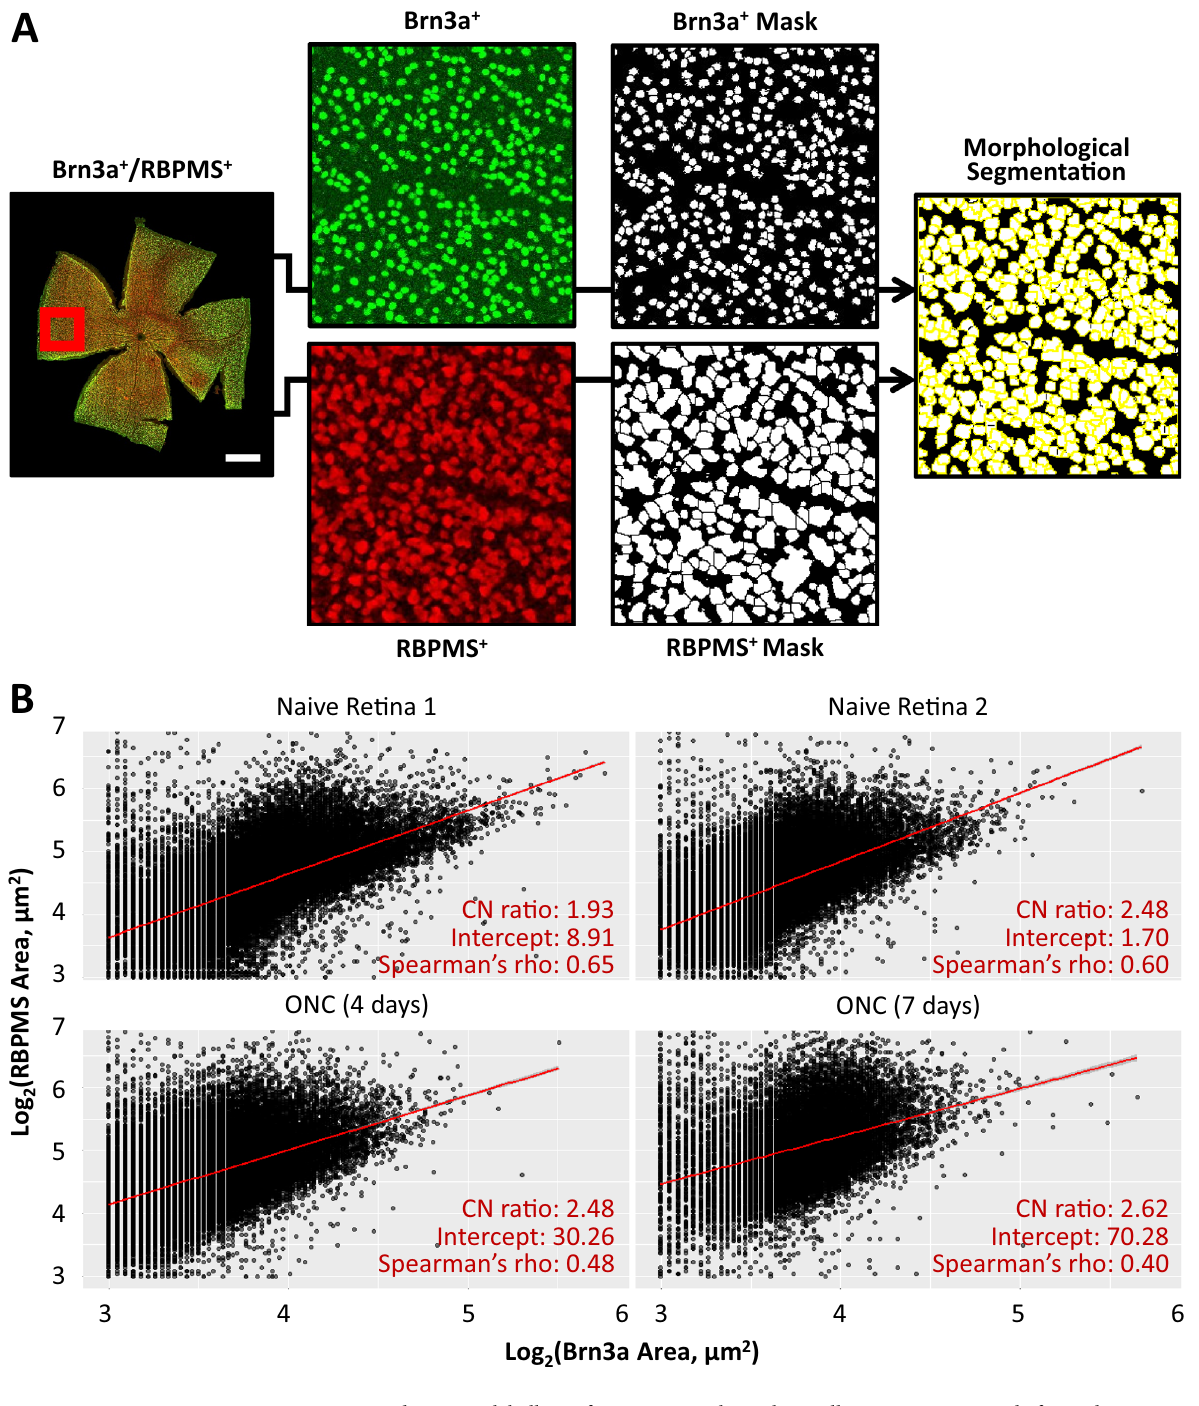
Figure 1. RBPMS and Brn3a colabelling of murine retinal ganglion cells in naive retina and after induction of optic nerve injury, using an established optic nerve crush model. ( A ) Illustration of the protocol for automatically measuring RGC cytoplasmic (RBPMS) and nuclear (Brn3a) area as described in the text. ( B ) Plots of Brn3a labelled area versus RBPMS labelled area in each retina with linear regression fit shown in red. Matching between Brn3a and RBPMS areas was achieved by calculating the cross-nearest neighbour distance between populations as described in the